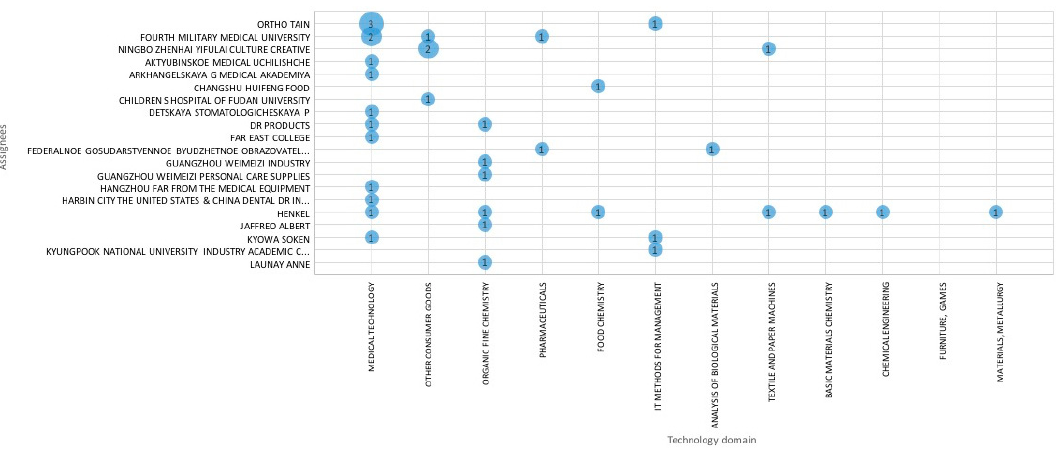
Figure 2. Patent families by Technology domain / Assignees. This graph represents the individual or the company that has rights and title to the invention (assignee) by technology domains. The size of the blue circles represents the number of the patent documents.